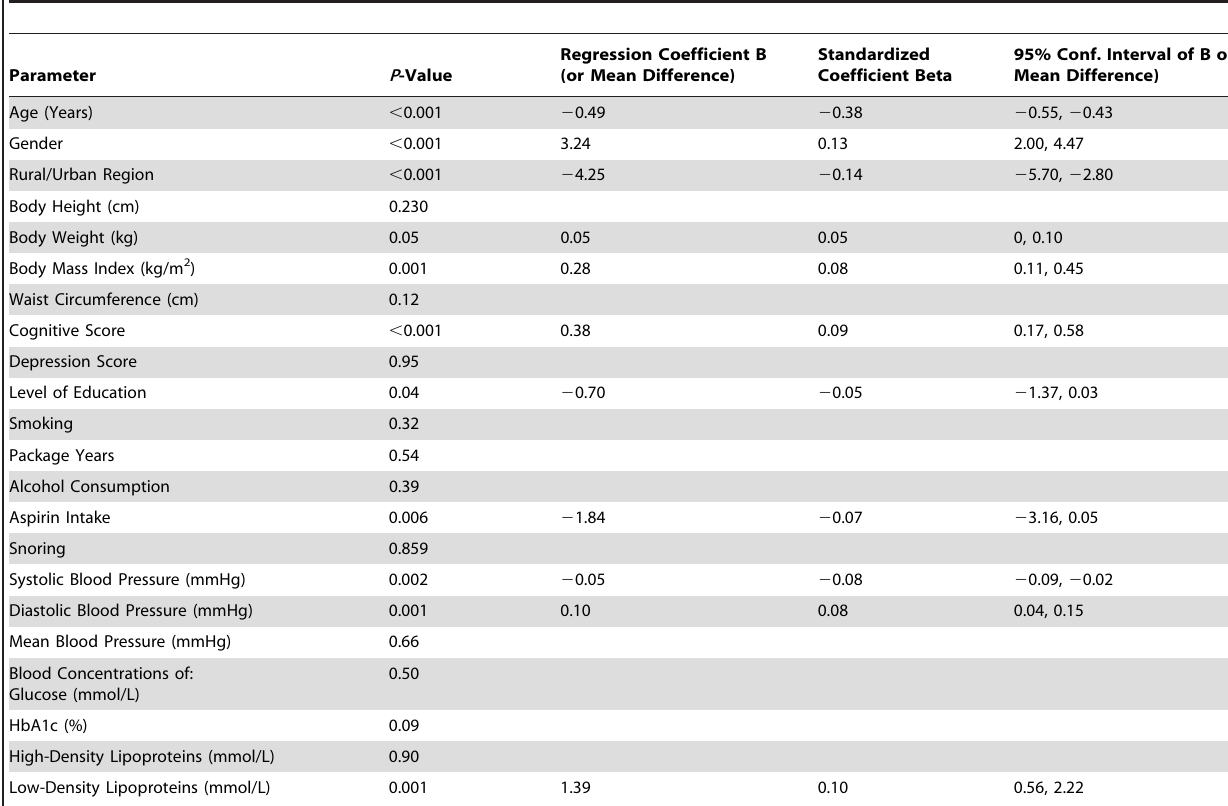
Table 1. Associations between mean global retinal nerve fiber layer thickness as measured by spectral domain optical coherence tomography (iVue SD-OCT) and ocular and systemic parameters in the Beijing Eye Study 2011 (univariate